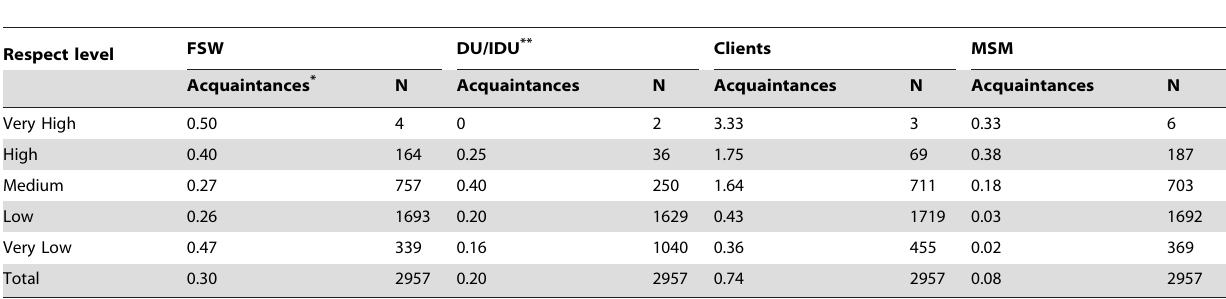
Table 4. The average number of acquaintances in KAP by respect level, Chongqing, China (2011).